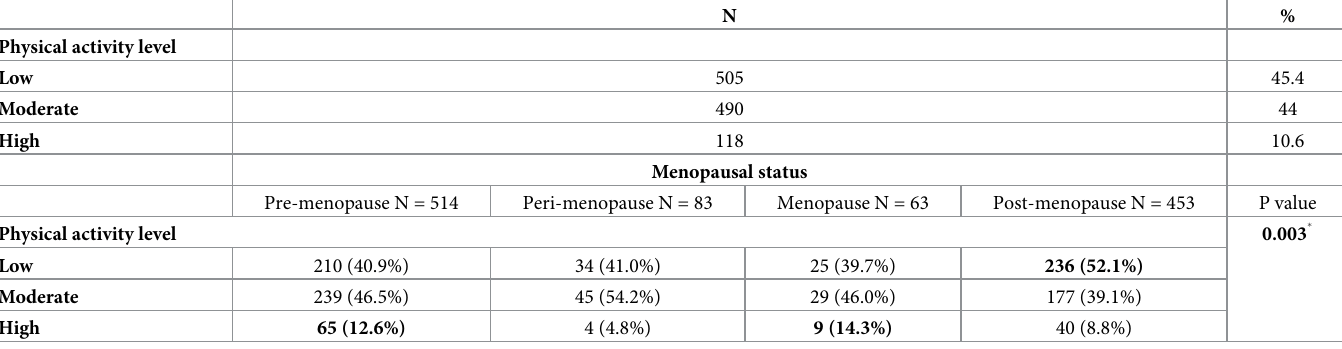
Table 4. Physical activity level of the participants and their classification according to their menopausal status. N